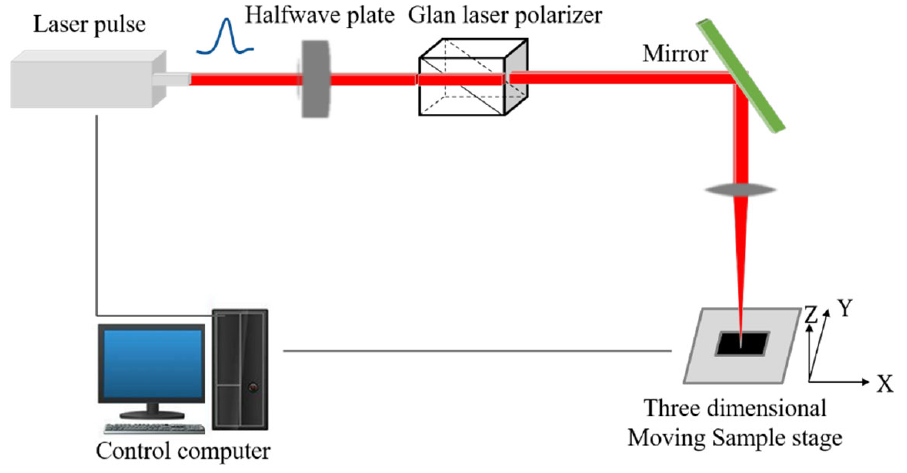
Figure 1. Schematic diagram of the experimental setup for laser processing.